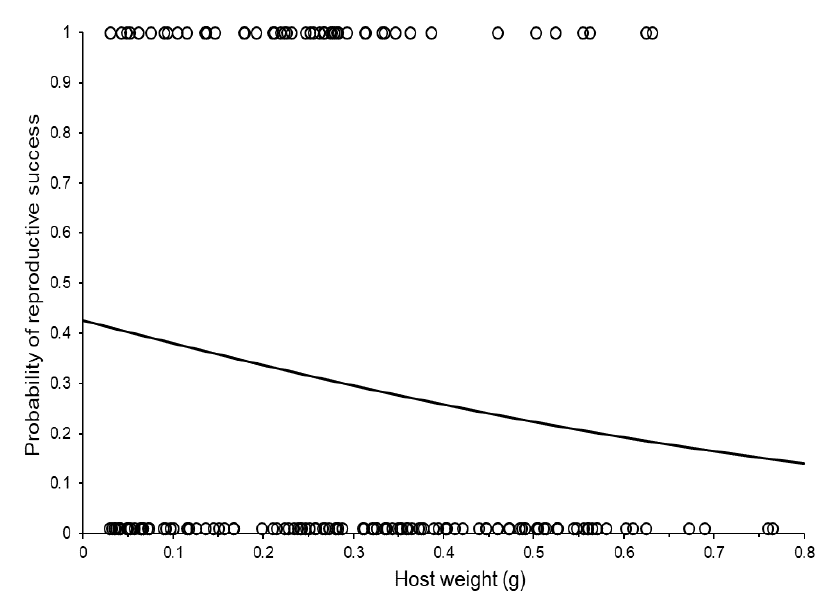
Figure 1. The probability of reproductive success of individual Sclerodermus brevicornis females according to the size of the host presented. The fitted curve was estimated using simple logistic regression and (estimated probability = 1/(1 + (1/(antiLog e (( − 1.9 × Host weight) − 0.3))). The relationship is marginally non-significant (see main text).